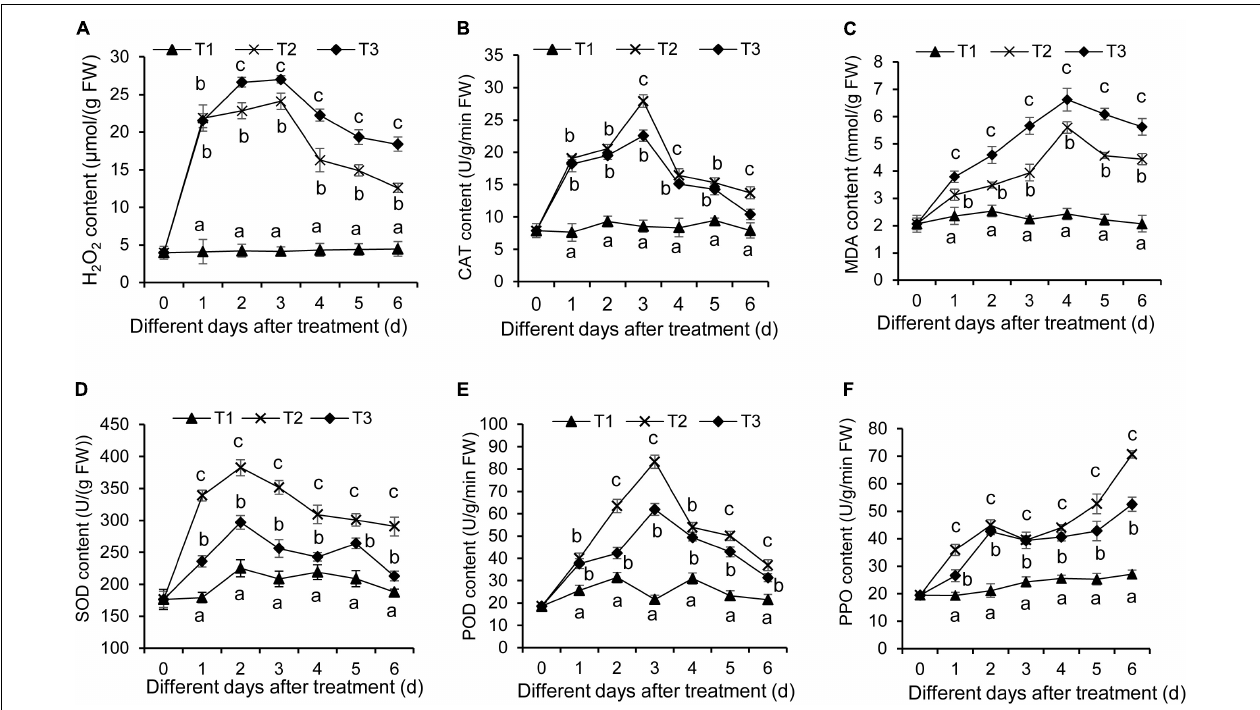
FIGURE 6 | Determination of hydrogen peroxide (A) , CAT (B) , MDA (C) , SOD (D) , POD (E) , and PPO (F) in banana roots after treatment with Streptomyces BITDG-11 at different time points. T1–T3 represent different treatment groups as in the description in Figure 5 . Error bars indicate standard errors of the means of three repeated experiments. Different letters indicate a significant difference in comparison with the medium treatment group at the same time points (LSD’s multiple range test, p <